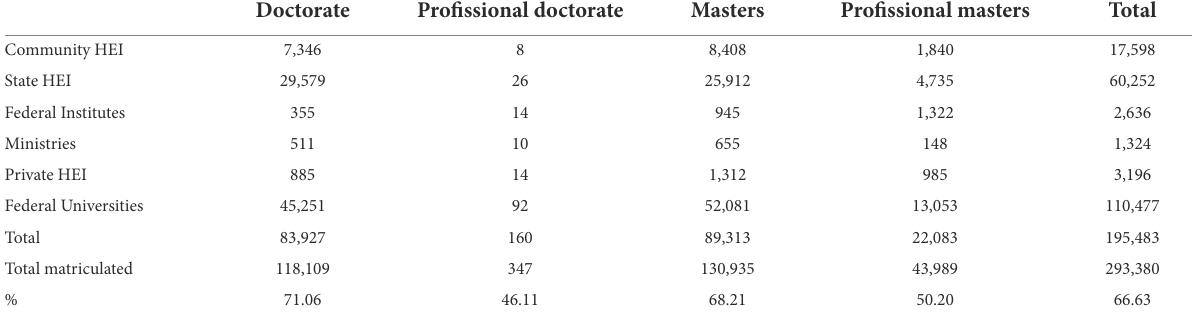
TABLE 2 Number and % of students in the respondent